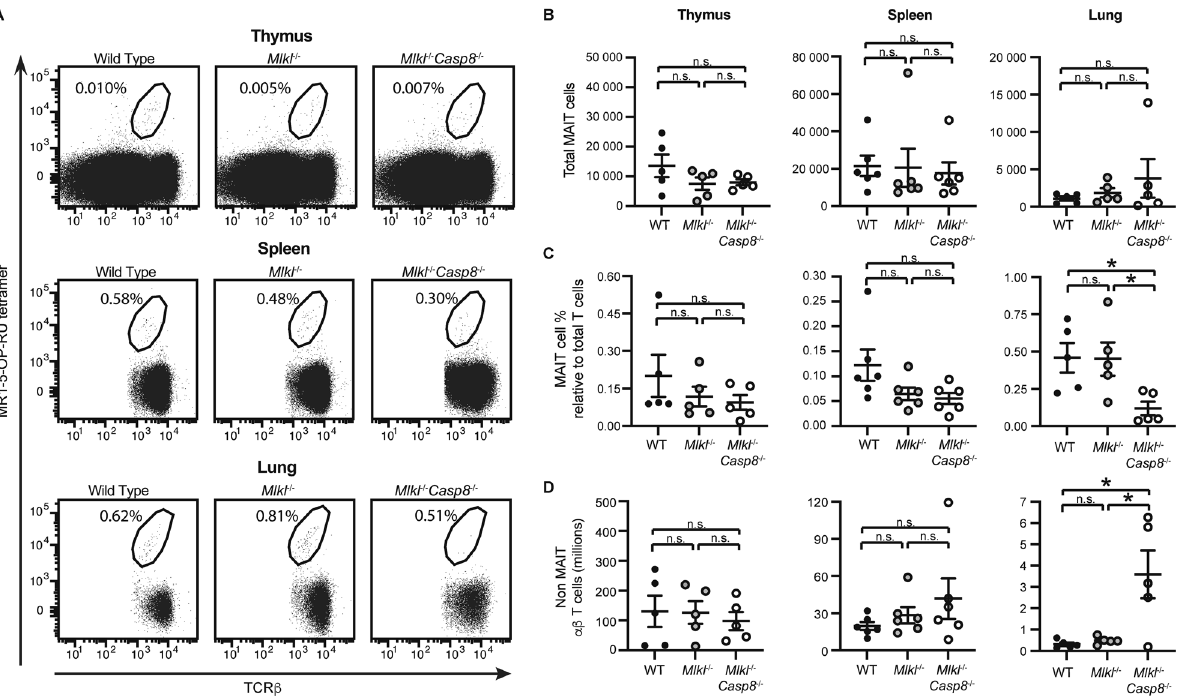
bacterial load in the liver or spleen of mice transferred with Ripk3 − / − or WT MAIT cells that survived to day 19 post infection (Fig. S6E). Similarly, there was no signi fi cant difference in the absolute number, proportion or tissue density of MAIT cells, between the WT and Ripk3 − / − MAIT cell recipients surviving at endpoint (Fig. S6F), indicating equivalent expansion of MAIT cells post transfer and infection. Collectively, these results suggest that RIPK3 de fi ciency does not impact MAIT cell expansion, contrac- tion, or MAIT-1 polarisation (at least in terms of their effector function through IFN- γ secretion) during infection, nor does loss of RIPK3 perturb MAIT cell capacity to control bacterial